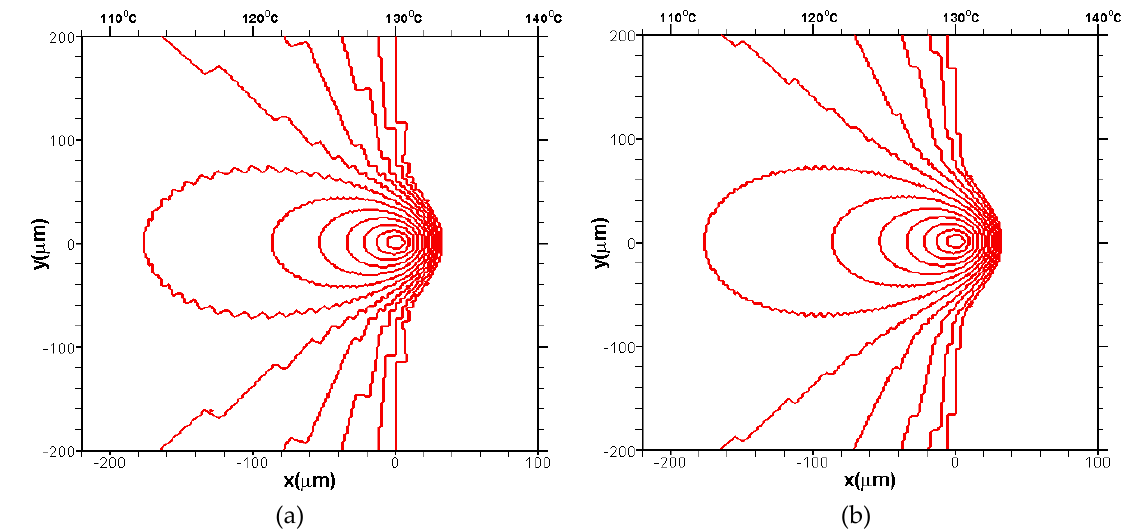
Figure 5. Spherulite shapes ( T 0 = 130 ◦ C, Λ = 100 K/mm) predicted with di ff erent divisional number of M in θ direction: ( a ) M = 100, ( b ) M =